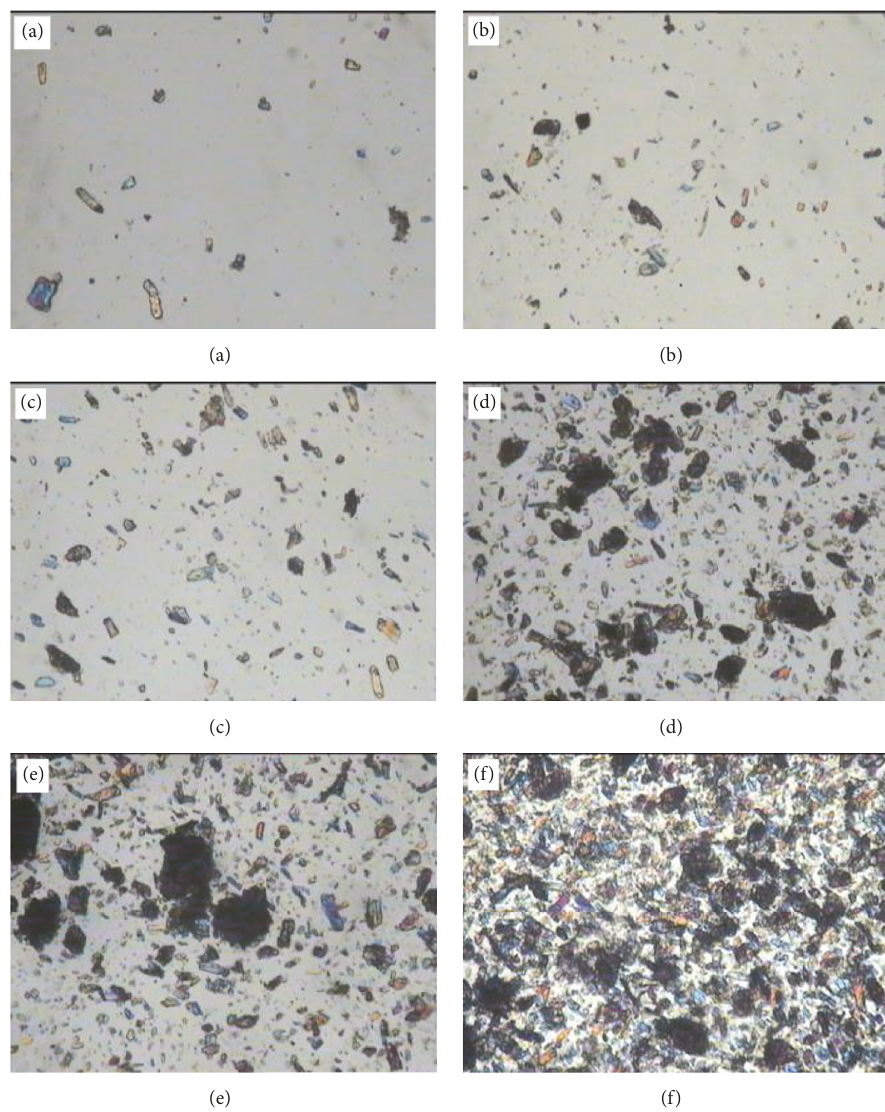
Figure 3: Polarized light photomicrographs showing the intensity and distribution of MCC particles within molten PP: (a) 0.5, (b) 1, (c) 2, (d) 5, (e) 10, and (f) 20 wt% MCC [magnification =